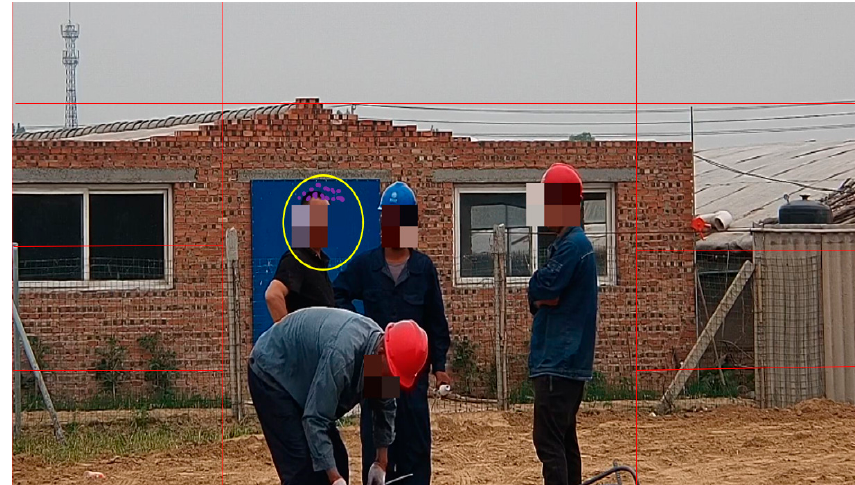
Figure 13. Safety helmet detection.